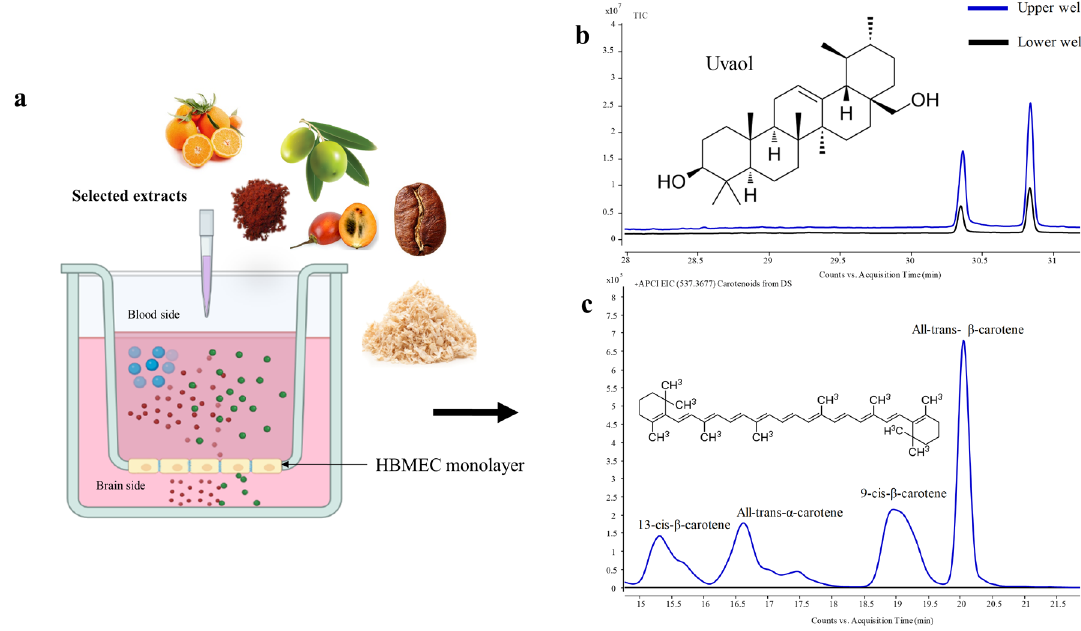
Figure 1. Schematic diagram of the experimental conditions and profiles obtained. The cell line of HBMEC was plated onto a semi-permeable membrane (transwell insert) placed inside a cell culture well defining two chambers: an upper or luminal one mimicking the blood compartment, and a lower or basolateral one that mimics the brain compartment ( a ). Uvaol from Olea europaea L. leaves (OL-SS) (total ion chromatogram, TIC) and carotenoids from Dunaliella salina (DS) (extracted ion chromatogram, EIC 547.3677 MW) were added to the upper chamber and their content was deter- mined in the upper and lower chambers ( b and c , respectively).